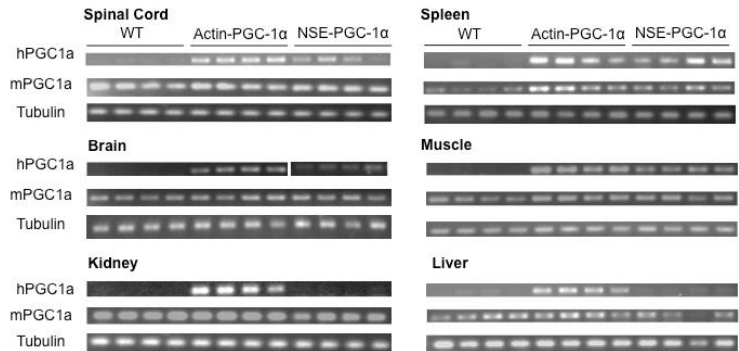
Figure 2. Tissue specificity of PGC- 1α transgene expression. RNA was isolated from the brain, spinal cord, muscle, liver, kidney, and spleen of wild-type (WT), actin-PGC- 1α , and NSE-PGC- 1α mice. Expression of human PGC- 1α, mouse PGC - 1α , and mouse tubulin were detected following RT-PCR. Data are from n = 4 mice per group.